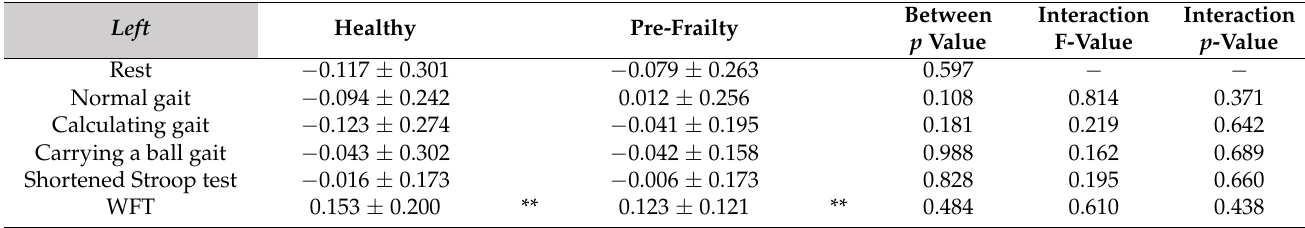
Table 2. Comparison of fNIRS results in the left and right prefrontal